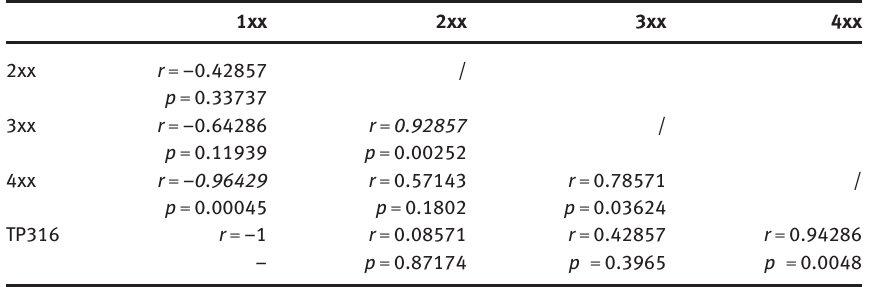
Table 2: Spearman correlation analysis for five materials in 700°C, KCl condition.